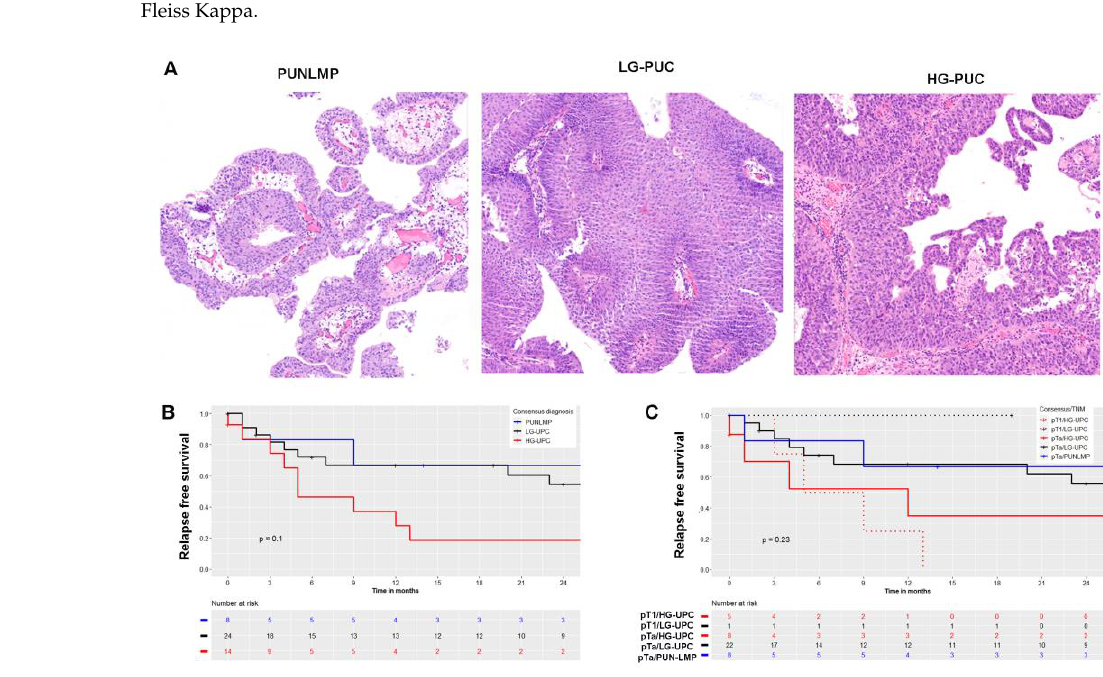
Meier analysis of relapse-free survival comparing TNM classification and tumor grades.